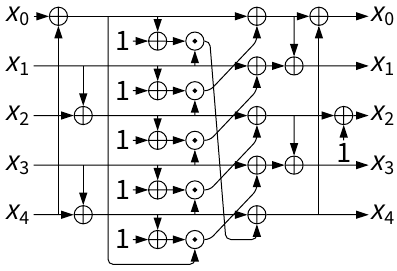
Figure 3: Ascon ’s S-box S